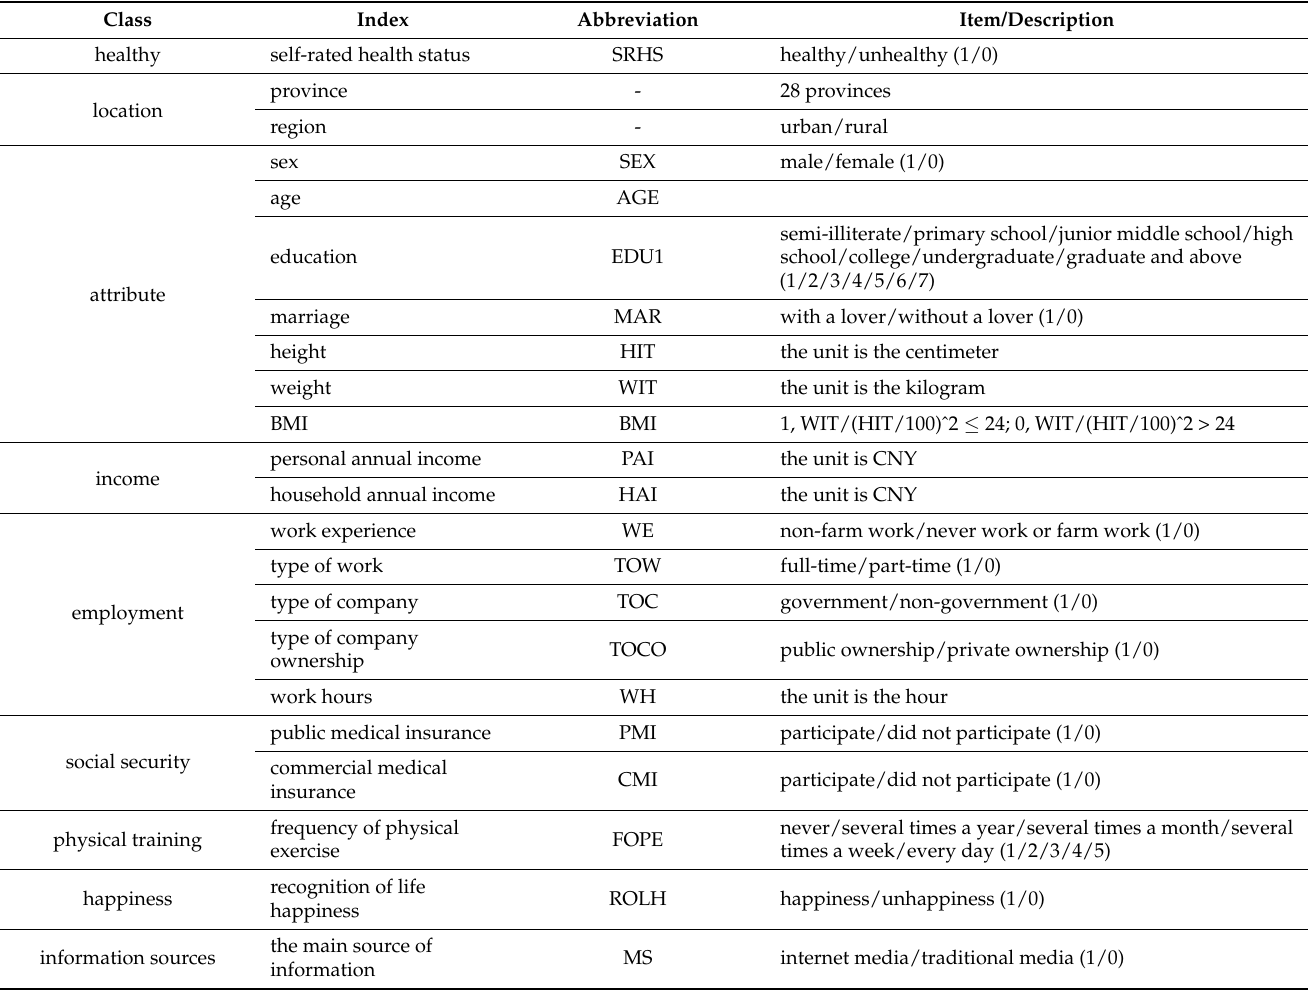
Table 1. Individual